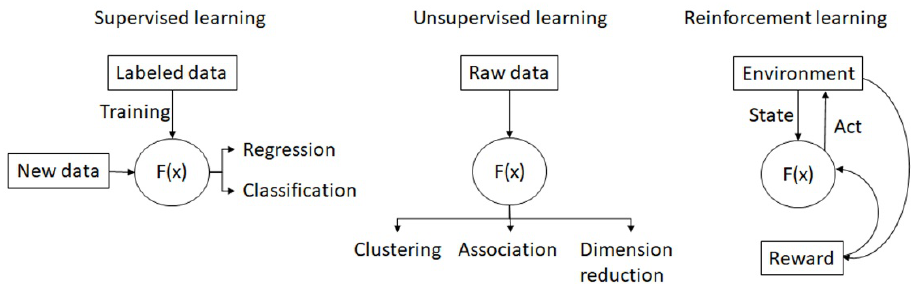
Figure 2. The concept map of supervised learning, unsupervised learning and reinforcement learn-